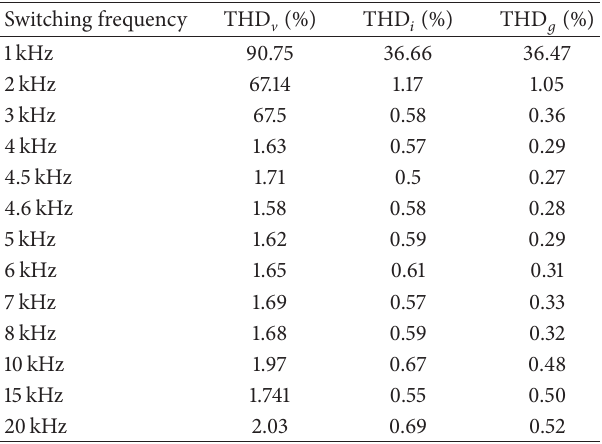
Table 2: Model parameters of PMSG based